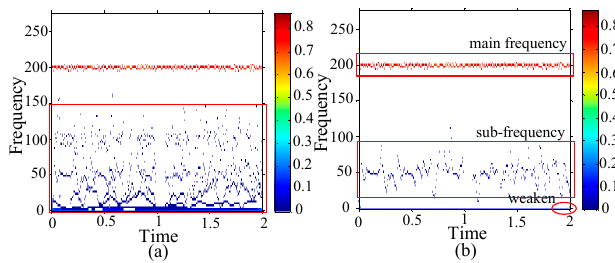
Figure 21. One 1.0 mm hole on inner race ( a ) HHT ( b ) GEMD-HHT spectrum.